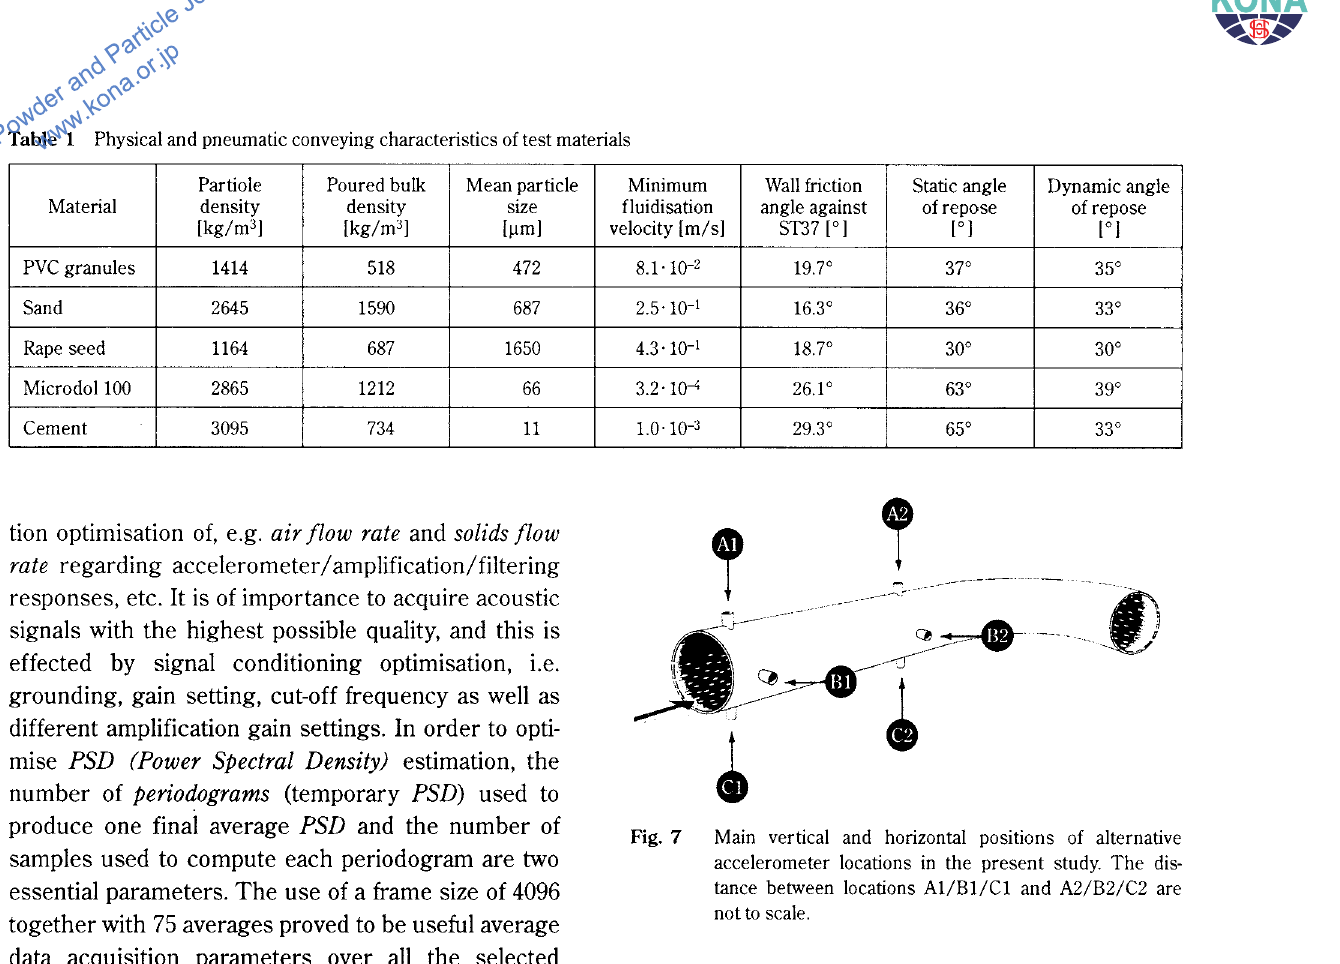
Fig. 7 Main vertical and horizontal positions of alternative accelerometer locations in the present study. The dis tance between locations A1/Bl/C1 and A2/B2/C2 are not to